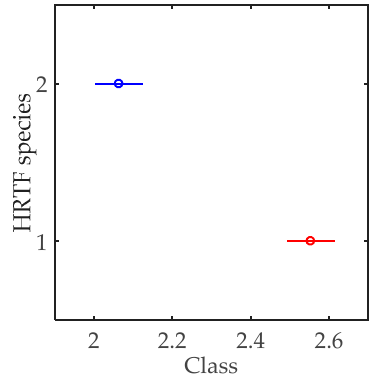
Figure 12. The result of post-hoc for ANOVA. X-axis denotes the evaluation class. Y-axis denotes the testing HRTF species of (1) individualized HRTFs and (2) non-individualized HRTFs. Red and blue lines denote the HRTF species of individualized one and non-individualized one, respectively. Circles on the lines denote the mean class of the corresponding HRTF species. The lengths of the lines denote the mean confidence intervals of the corresponding HRTF species.